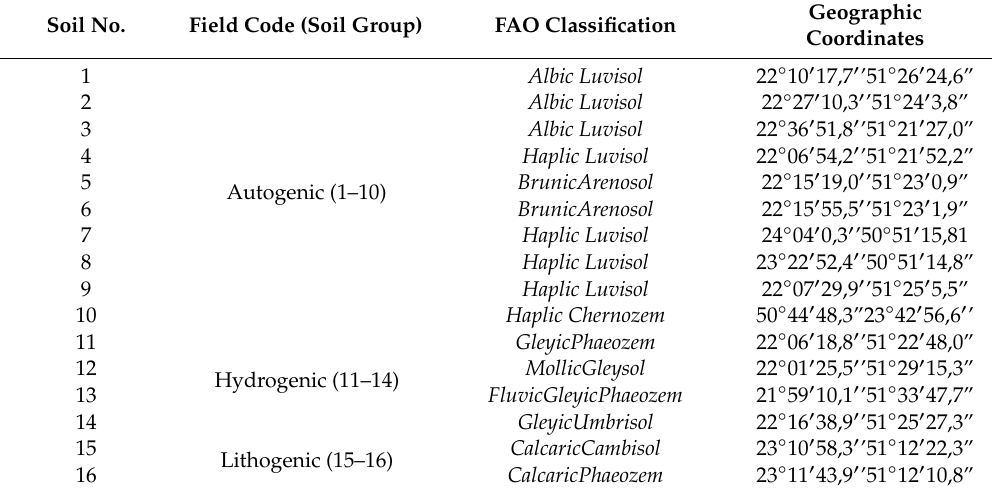
Table 1. Localization of the soil sampling sites (South-East—SE Poland) with Food and Agriculture Organization of the United Nations—FAO classification.